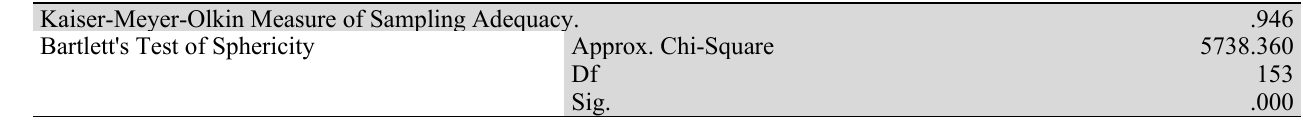
KMO and Bartlett's Test Kaiser-Meyer-Olkin Measure of Sampling